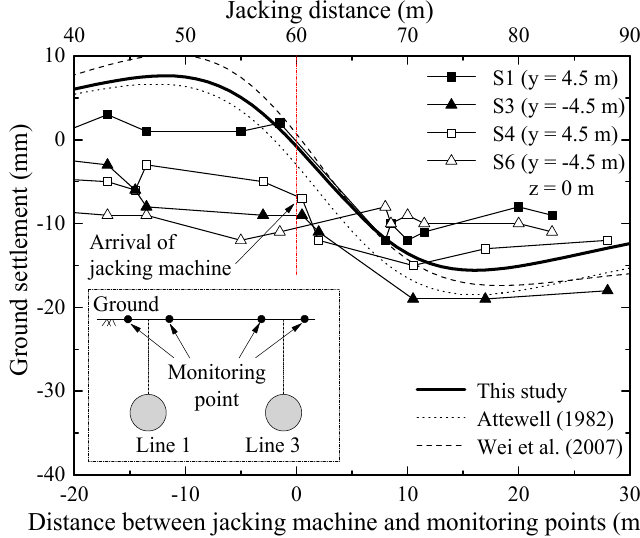
Figure 13. Ground settlements adjacent to Line 1 and Line 4 at ground surface.